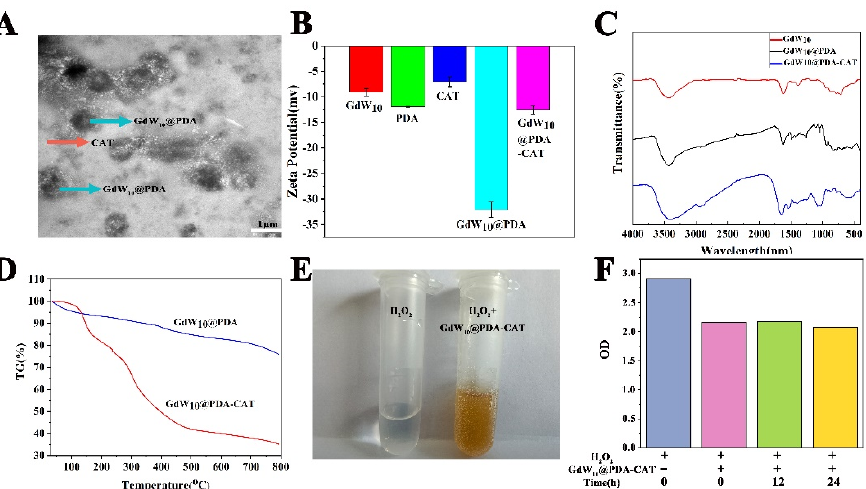
Figure 1. Characterization of GdW 10 @PDA-CAT. ( A ) TEM image of the as-synthesized GdW 10 @PDA-CAT. ( B ) IR spectra of GdW 10 , GdW 10 @PDA, and the as-fabricated GdW 10 @PDA-CAT. ( C ) Zeta potential analysis of GdW 10 , PDA, CAT, GdW 10 @PDA, and GdW 10 @PDA-CAT. ( D ) TG curve of GdW 10 @PDA and GdW 10 @PDA-CAT. ( E ) O 2 production from the H 2 O 2 solution catalyzed